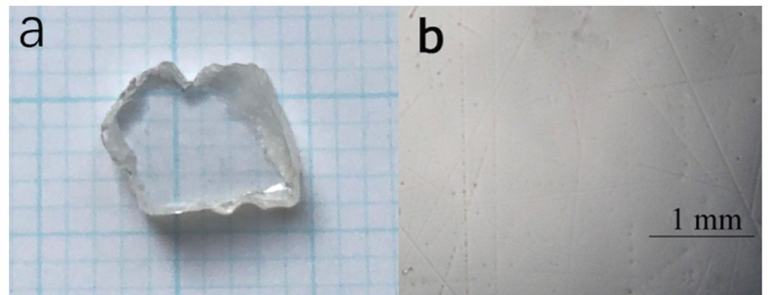
Figure 1. Photographs of ( a ) a wafer cut perpendicular to the growth direction and ( b ) the wafer under polarizing microscope in the transmission